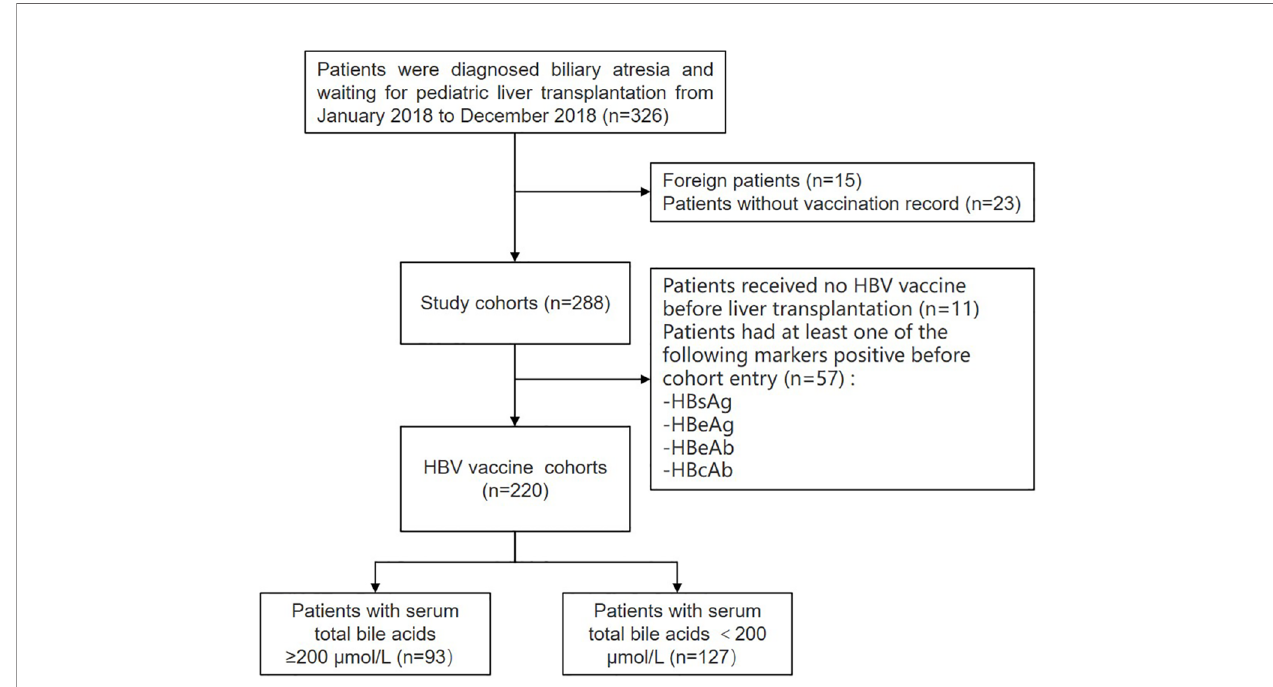
FIGURE 1 | Flow chart: enrollment of patients with biliary atresia. HBV, hepatitis B virus; HBsAg, hepatitis B surface antigen; HBeAg, hepatitis B e-Antigen; HBeAb, hepatitis B e-antibody; HBcAb, hepatitis B core